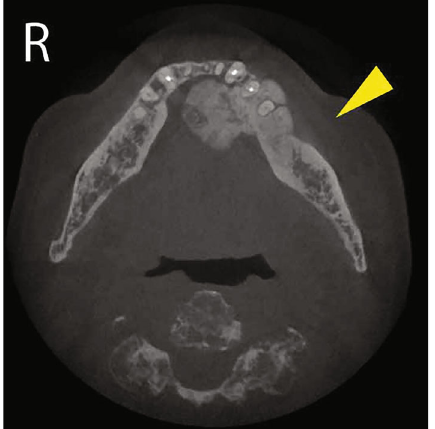
Figure 2: Cone-beam computed tomography showing the mass connected to the cortical bone of the mandible. The mass spread to the left mandibular body (arrowhead).